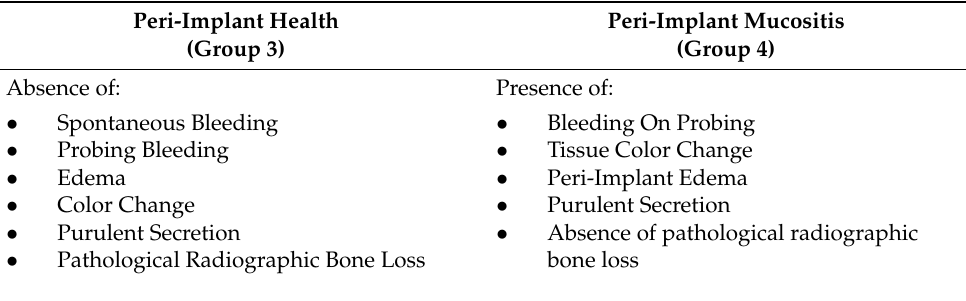
Table 1. Diagnosis of the peri-implant diseases studied (based on LINDHE & MEYLE, 2008)